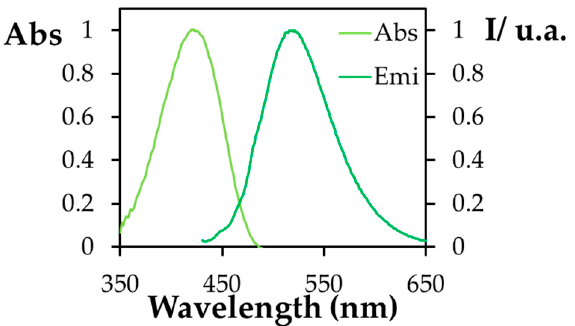
Figure 2. Normalized UV-visible absorption and emission spectra of the dicyanovinyl derivative 1 in ACN ( 1.0 × 10 − 5 M, λ exc = 421nm).